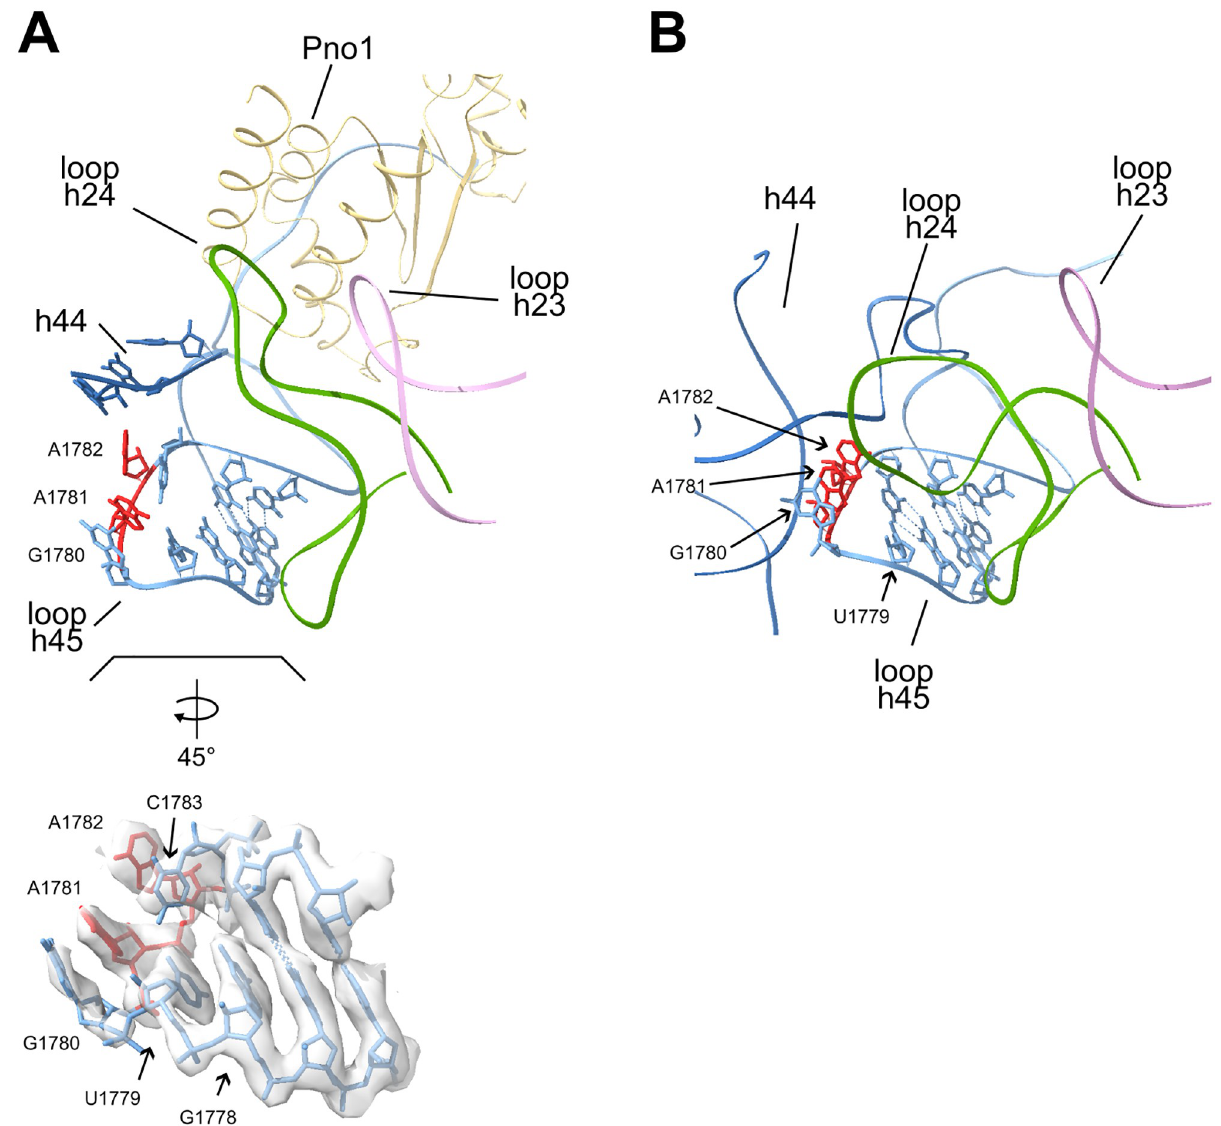
Fig 2. Structure model of helix h45 and its context in the Enp1TAP_A SSU precursor population (A) and in mature ribosomes (B). The backbone of helix h45 is shown in light blue, and the ones of h44, h23, and h24 are in dark blue, pink, and green, respectively. For nucleotides in the terminal loop of helix h45 atomic models are shown, with the substrate nucleotides of Dim1 (A1781 and A1782) in red. The lower insert in (A) shows the terminal loop of helix h45 further enlarged, rotated by 45 degrees, and overlayed with the cryo-EM derived map of Enp1TAP_A SSU precursors. Pdb entry 4v88 was used for the visualization of mature